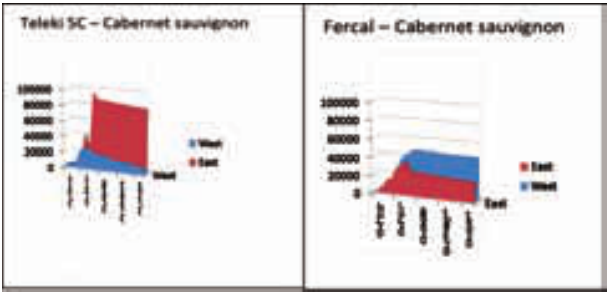
Figure 2: Total area (mm 2 ) of the T5C and Fercal roots in 0-1000mm depth of soil observed in minirizhotron tubes at east and western side of the grapevine rows